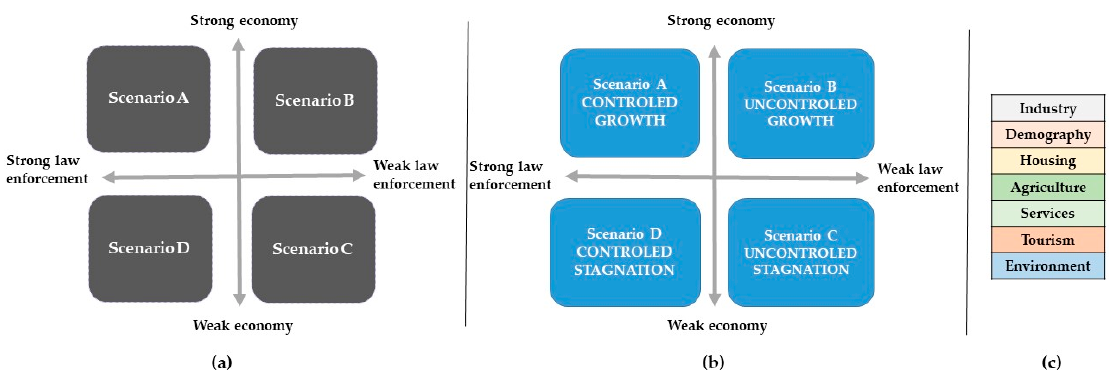
Figure 4. The development of the scenario space (a), and the scenarios (b), and the primary sectors for the city urban expansion (c).